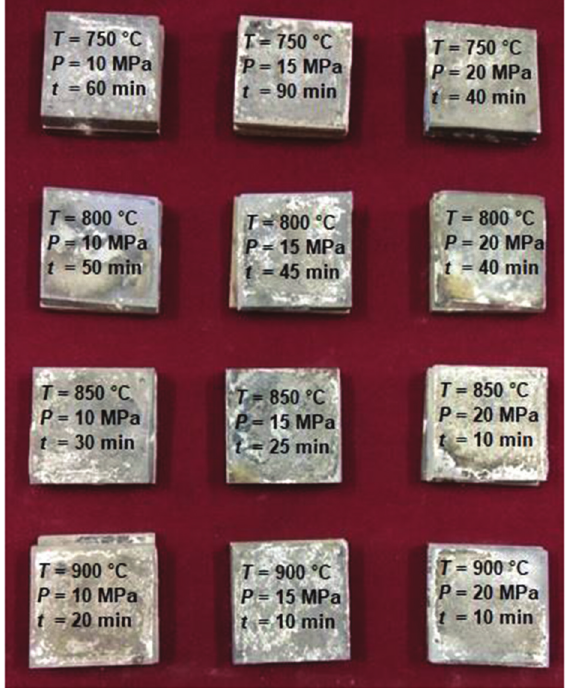
Figure 3: Diffusion bonded